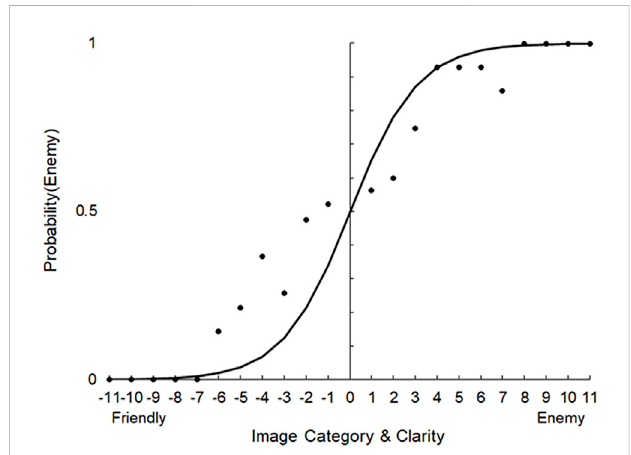
FIGURE 3 Psychometric function relating image category (friendly versus enemy) and image clarity ( − 11 to 11) to the probability of a participant categorizing the image as Enemy during the DMT pilot study (stimulus version